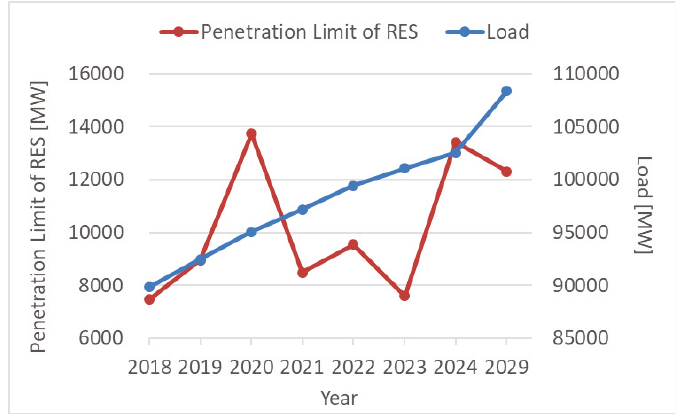
Figure 9. Penetration limit of RES calculated by the frequency stability.